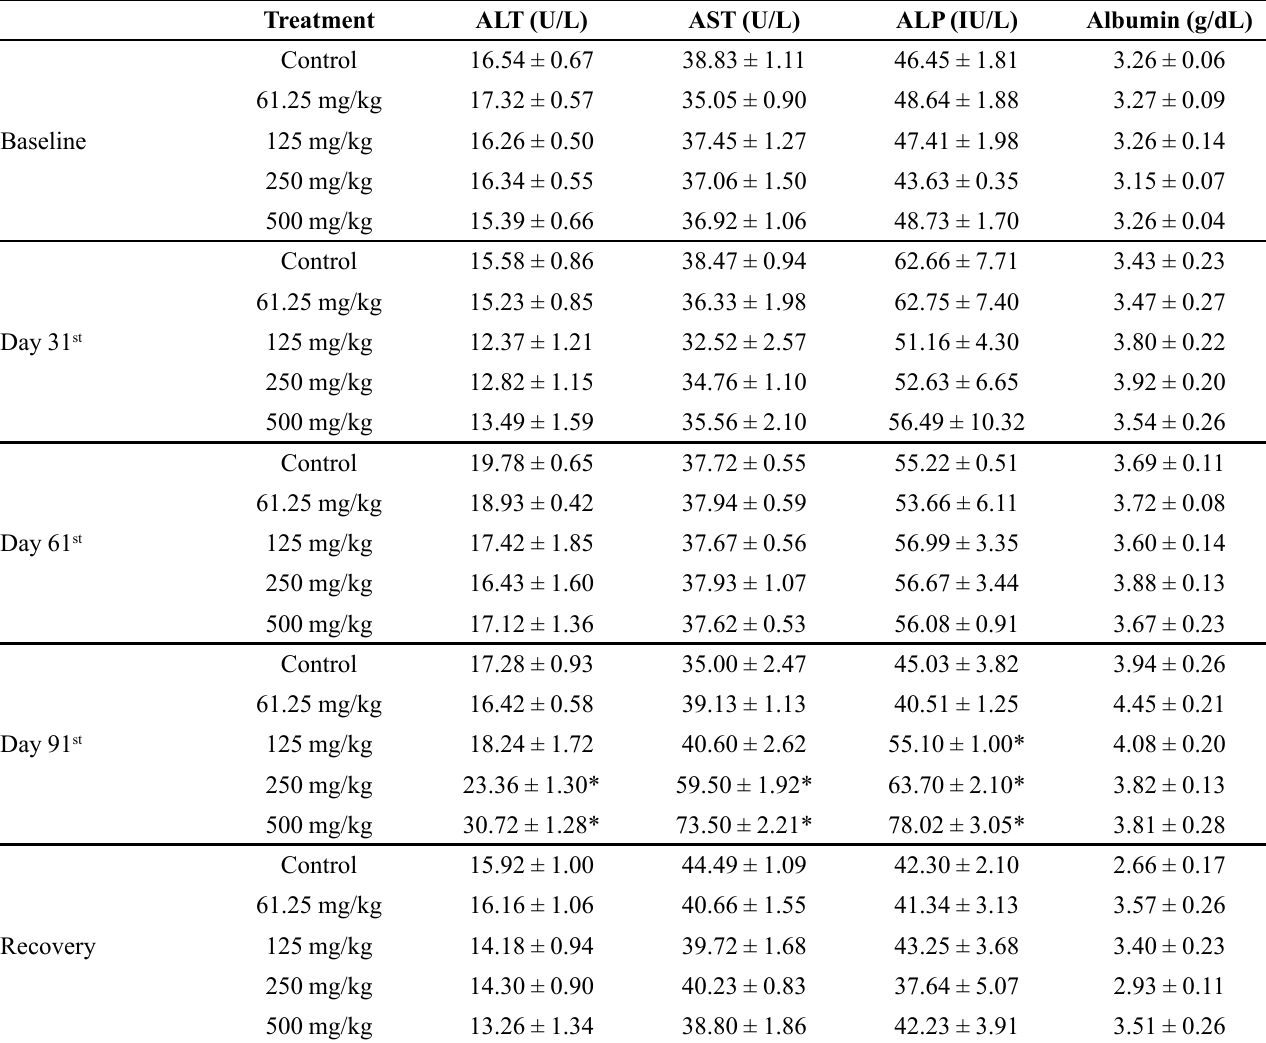
TABLE VI - Effect of sub-chronic administration of Dryopteris filix-mas ethanol leaf extract on Liver enzymes, alanine aminotransferase (ALT), aspertate aminotransferase (AST), alkaline phosphatase (ALP), total protein and albumin of albino